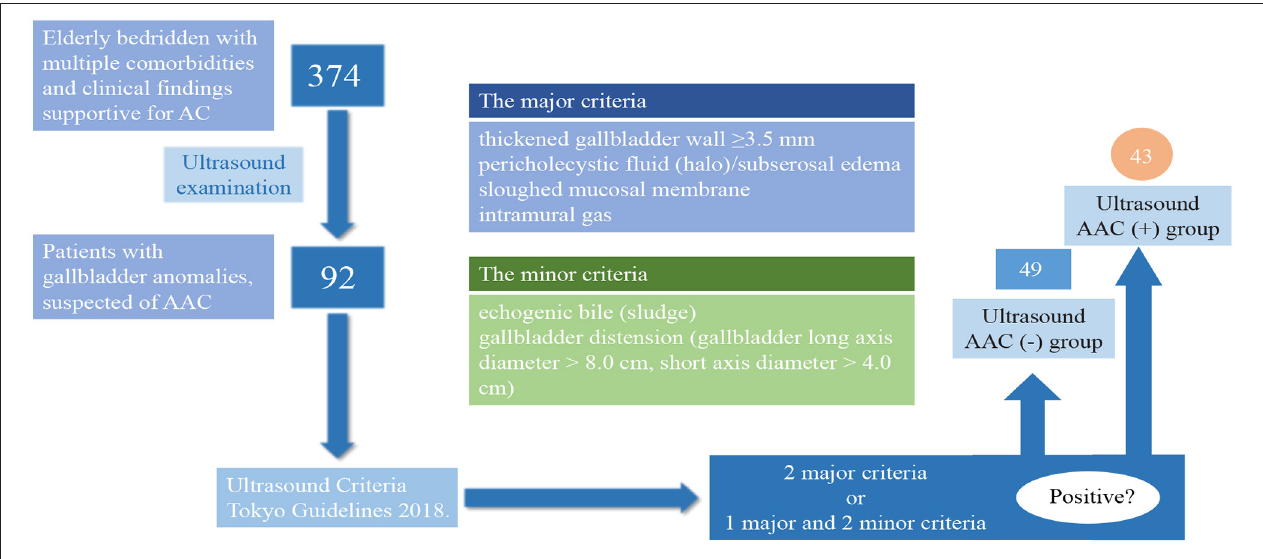
FIGURE 1 | AAC ultrasonic examination criteria and a flowchart detailing the patient